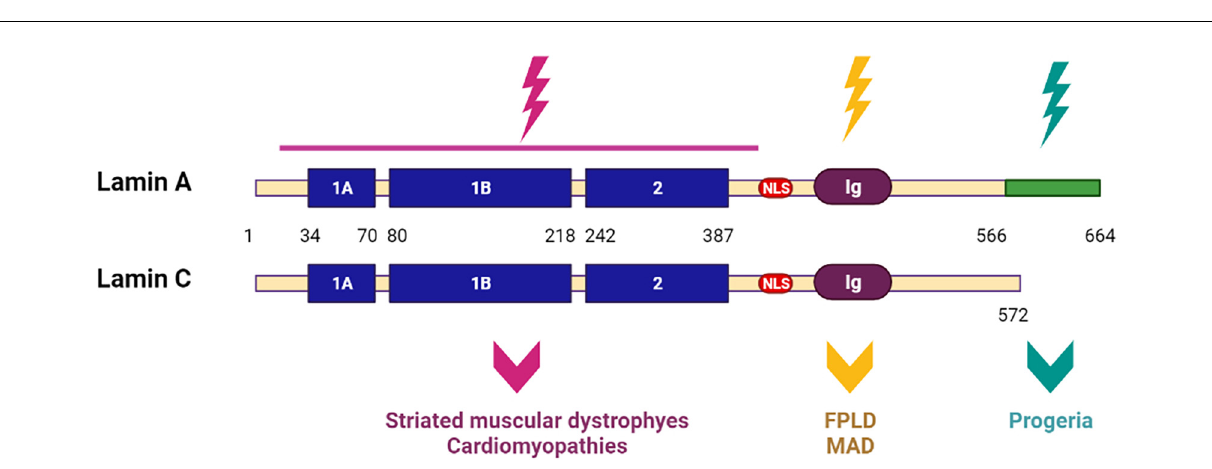
FIGURE 9 | Scheme of lamin A and lamin C structures with mutated regions. LMNA mutations upstream of the nuclear localization signal (NLS) affect the conserved core domain. Resulting in striated muscular dystrophies and cardiomyopathies. LMNA mutations located downstream of NLS lead to progeroid syndromes, Dunnigan-type familial partial lipodystrophy (FPLD) and mandibuloacral dysplasia (MAD). Created with